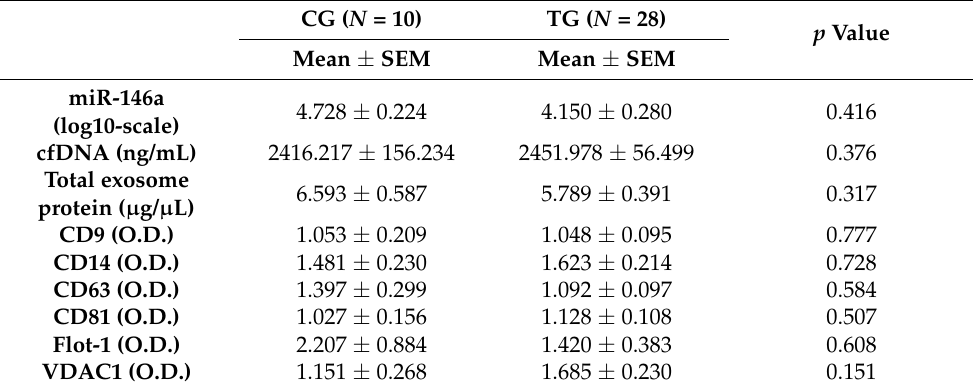
Table 4. The baseline levels of miR-146, cfDNA, total exosome protein content, and exosome cargo between CG and TG.